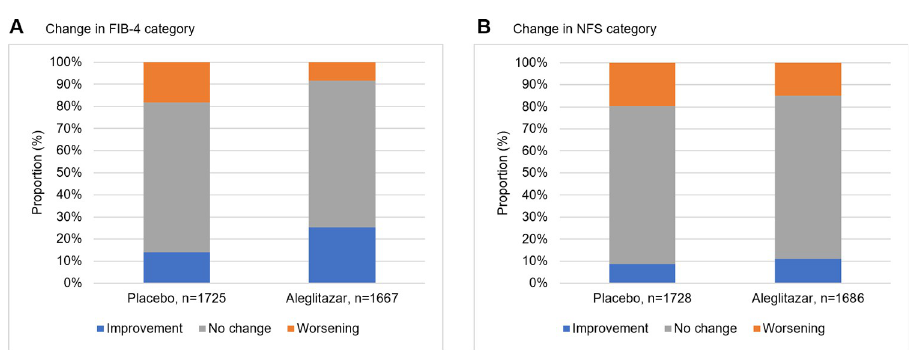
Fig 3. Change in FIB-4 and NFS category from baseline until 24 months follow-up. Proportion of randomized patients that either improved (changed to a lower category), worsened (changed to a higher category) or did not change in category. Proportion of change is significantly different between treatment and placebo for FIB-4 (A) and NFS (B) . FIB-4: Both improvement and worsening P < 0.001, NFS: Improvement P < 0.004, worsening P = 0.024.